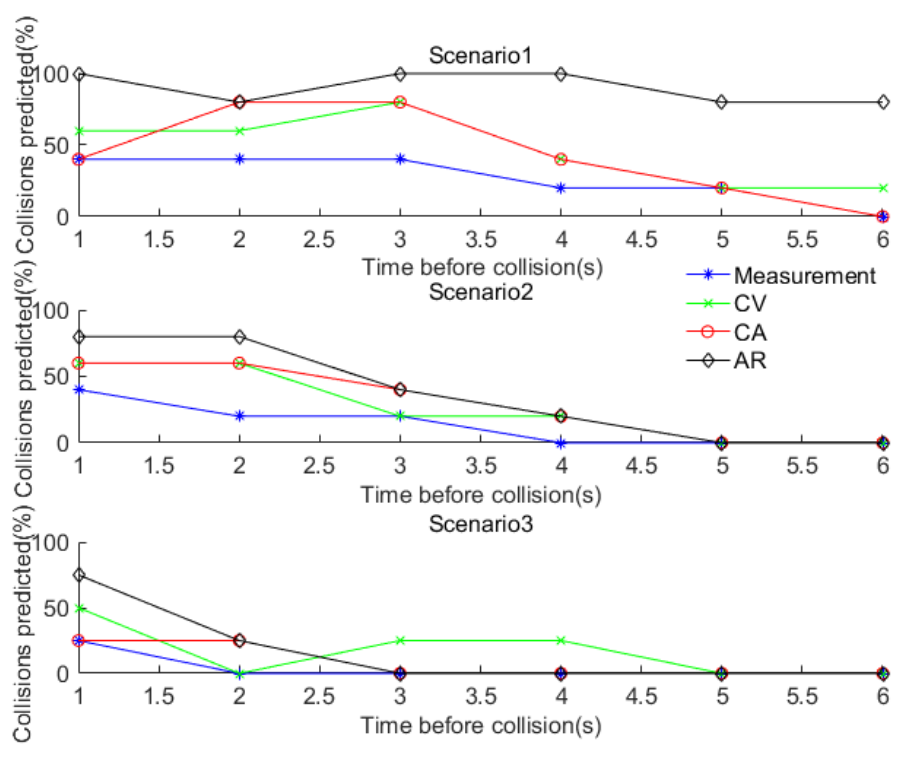
Figure 13. Collision prediction for the field test.